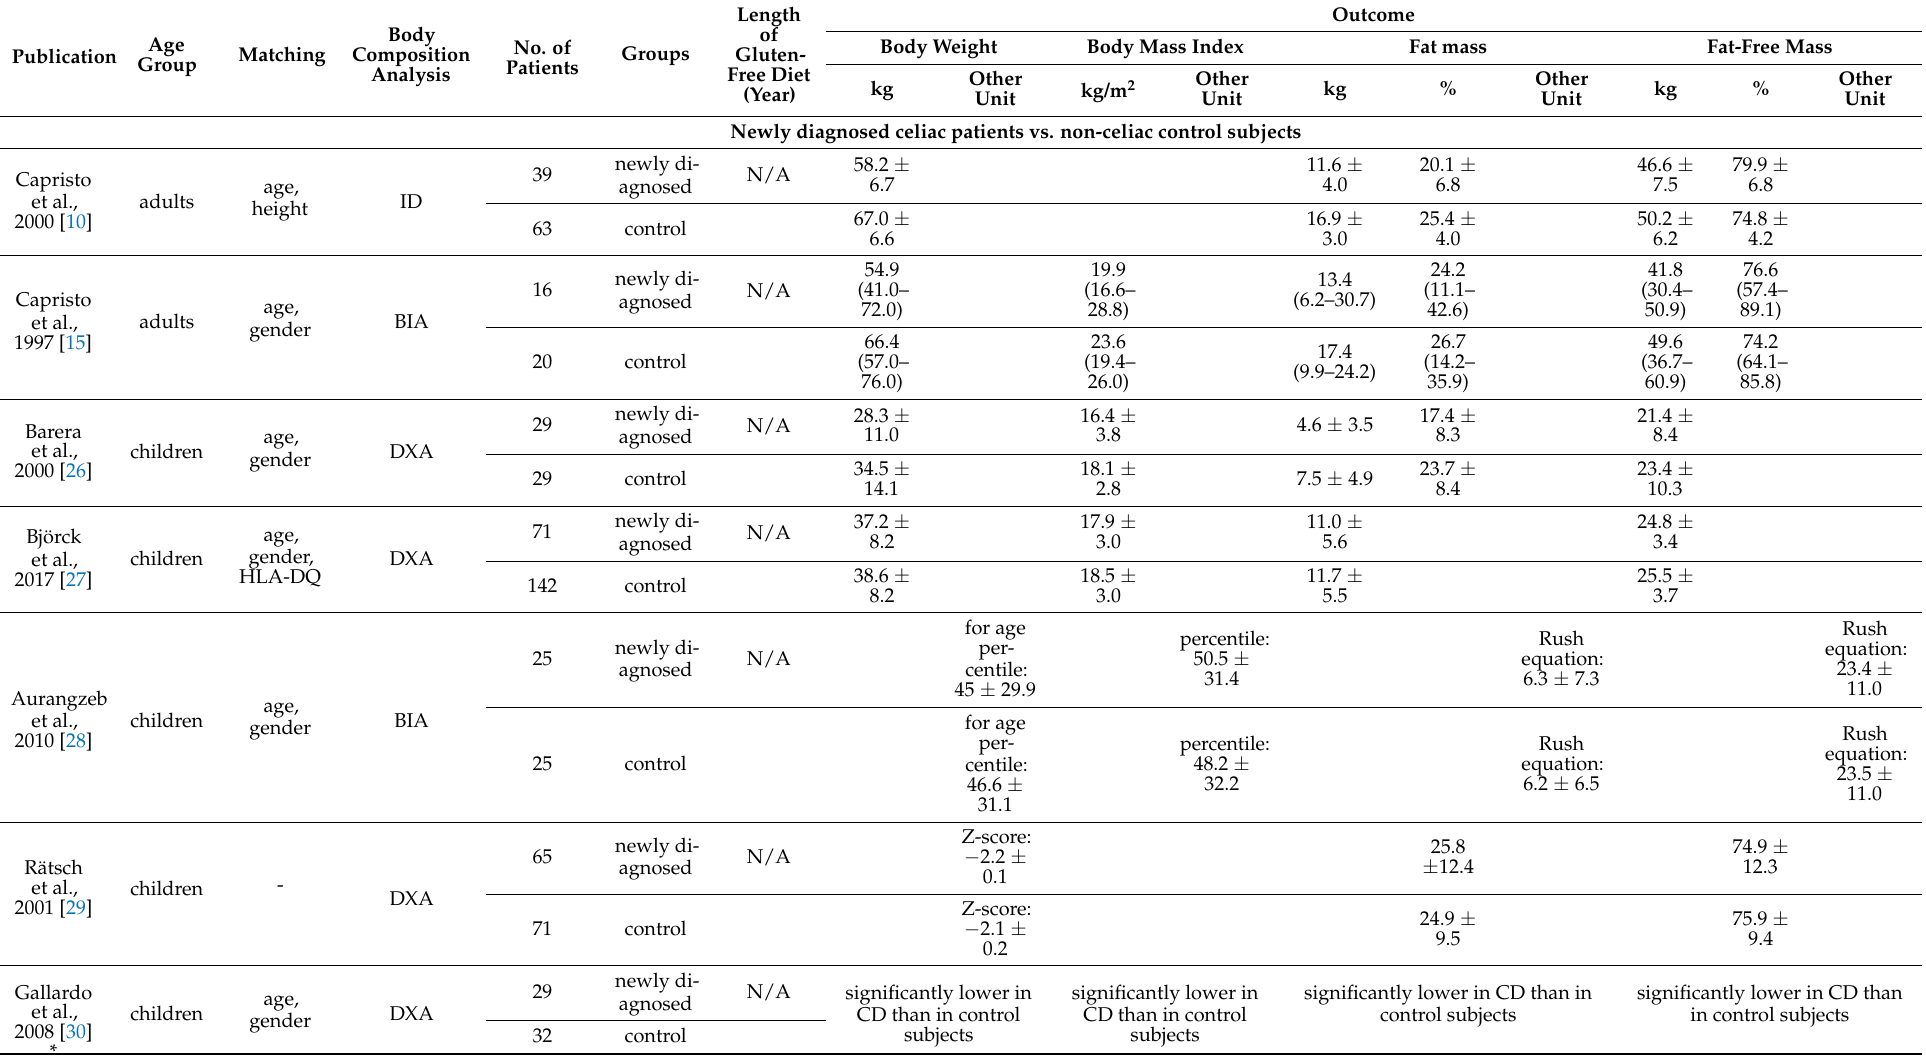
Table 1. Characteristics of the studies included in systematic review and